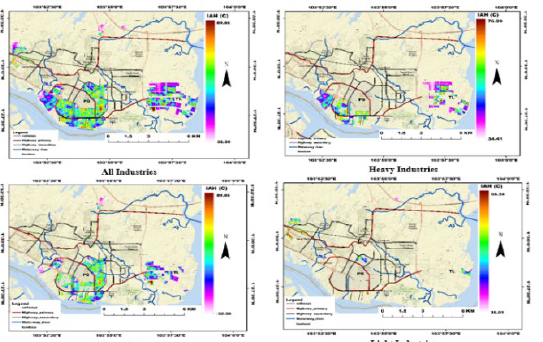
Table 7. Statistical spatial distribution for Keck Seng field data